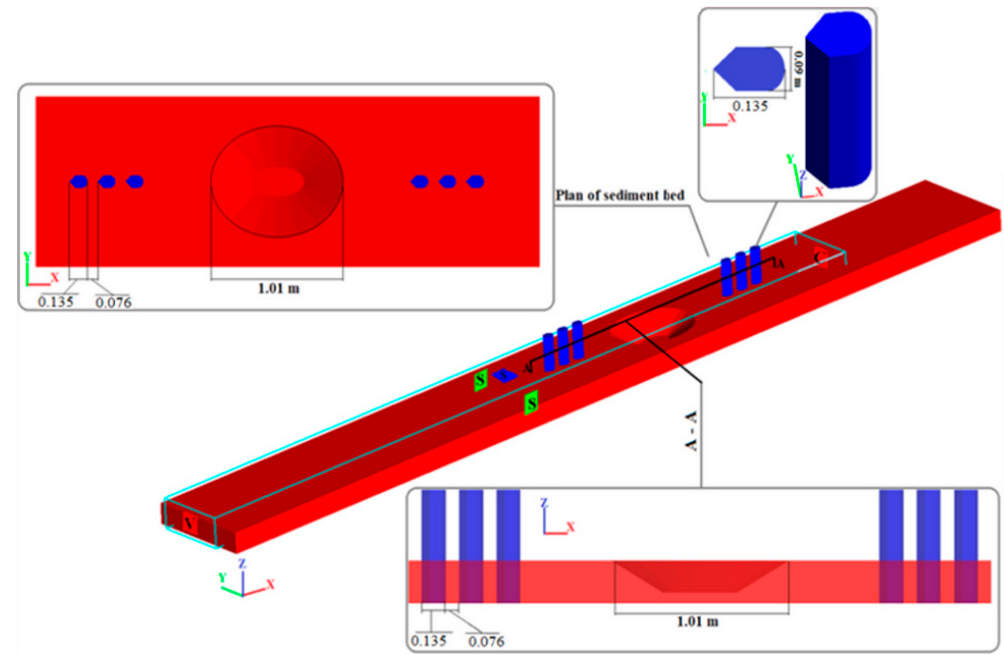
Figure 5. 3D view of the hydrodynamic pile groups and the sediment bed (all dimensions are in meters).